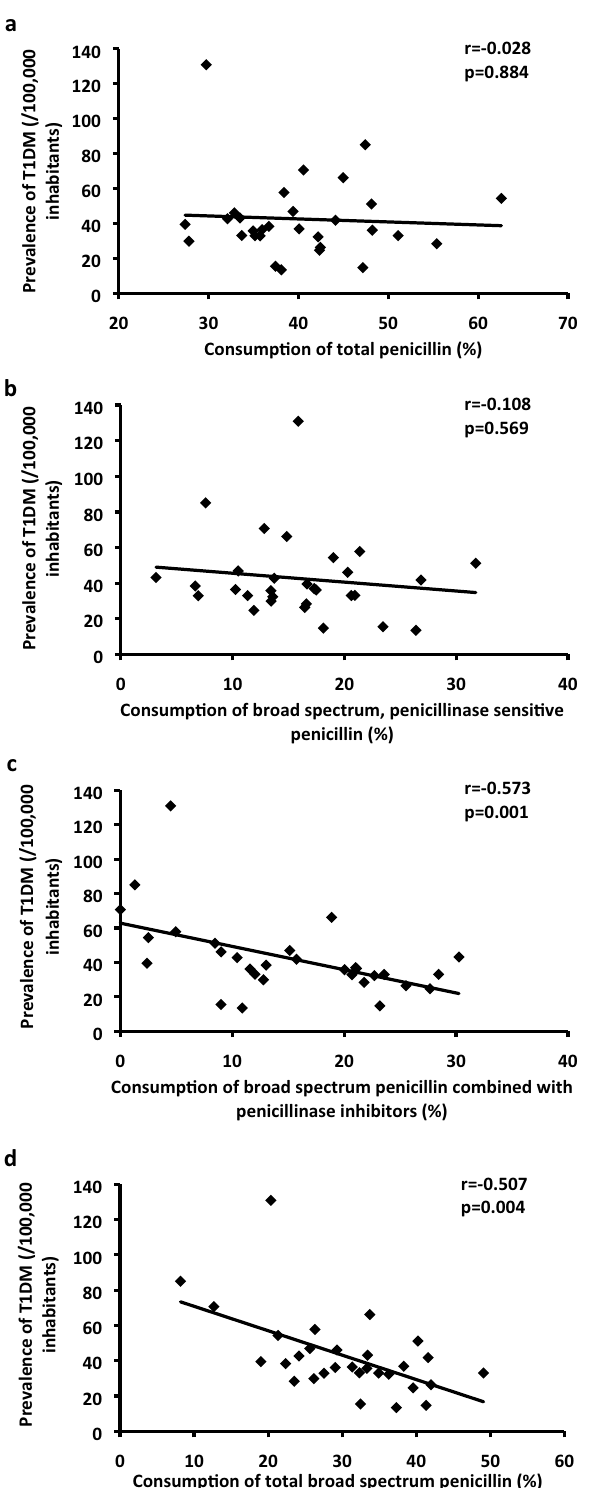
Figure 1. Association of consumption of total penicillin ( a ), broad spectrum, penicillinase sensitive penicillin ( b ), broad spectrum penicillin combined with penicillinase inhibitors ( c ) and total broad spectrum penicillin ( d ) with prevalence of T1DM (0–19 years). Total broad spectrum penicillin represents broad spectrum, penicillinase sensitive penicillin + broad spectrum penicillin combined with penicillinase